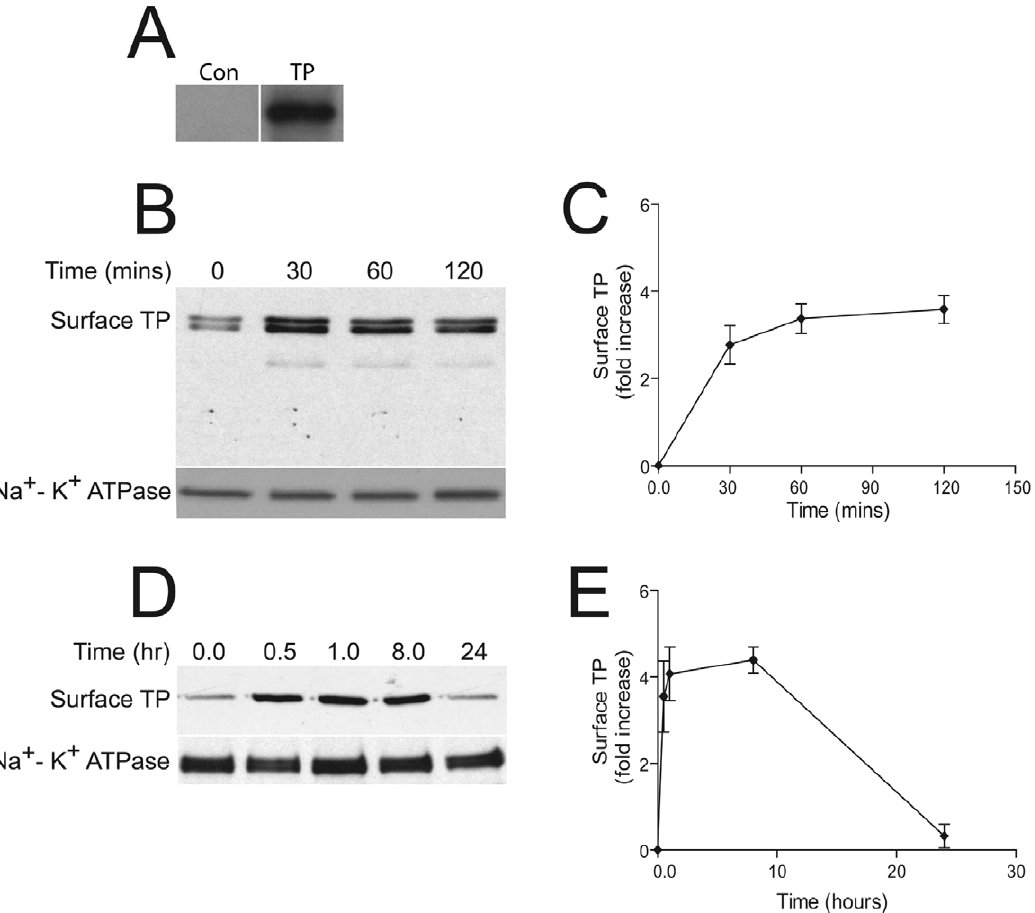
Figure 1. Effects of hydrogen peroxide exposure on cell-surface expression of TP b . Panel A: HA-TP b is detected only in transfected HEK293 cells. Cell-surface TP b was labeled using a water-soluble biotin analogue and recovered with streptavidin beads. Steptavidin-bound proteins were analysed by immunoblotting using anti-HA antibodies. Lane 1 (Con) is the nontransfected negative control and lane 2 (TP) is transfected cells. Note the blot is from the same membrane but lanes have been rearranged for presentation only, and the greater density of the band here compared to panels B and C is due to longer exposure to enhance the negative control. Panels B-E: HEK293 cells stably expressing TP b were incubated in DMEM, stimulated with 10 m M (final) hydrogen peroxide and then incubated for the times indicated. Cell-surface TP b was detected as for panel A. Equal loading was confirmed by re-probing of membranes with antibodies against the Na + -K + ATPase. Cell-surface levels were monitored over two hours (Panel B) or up to 24 hours (Panel D). Note doublet on panel B is due to a loading artifact from high volume samples and is seen only in some blots and does not indicate the presence of an additional form of TP b . Panels C and E represent quantified data for panels B and D respectively where the values are means 6 SEM of three independent experiments. Note that these graphs report ‘fold increase’ in surface TP expression; 0 represents no change from resting state expression. These data show that cell-surface HA-TP b increases following H 2 O 2 exposure , 3.5 fold-increase after 2 hours. The extended time course in panels D and E demonstrates the H 2 O 2 -induced augmentation of cell-surface is sustained for at least 8 hours declining to resting values by 24 hours.